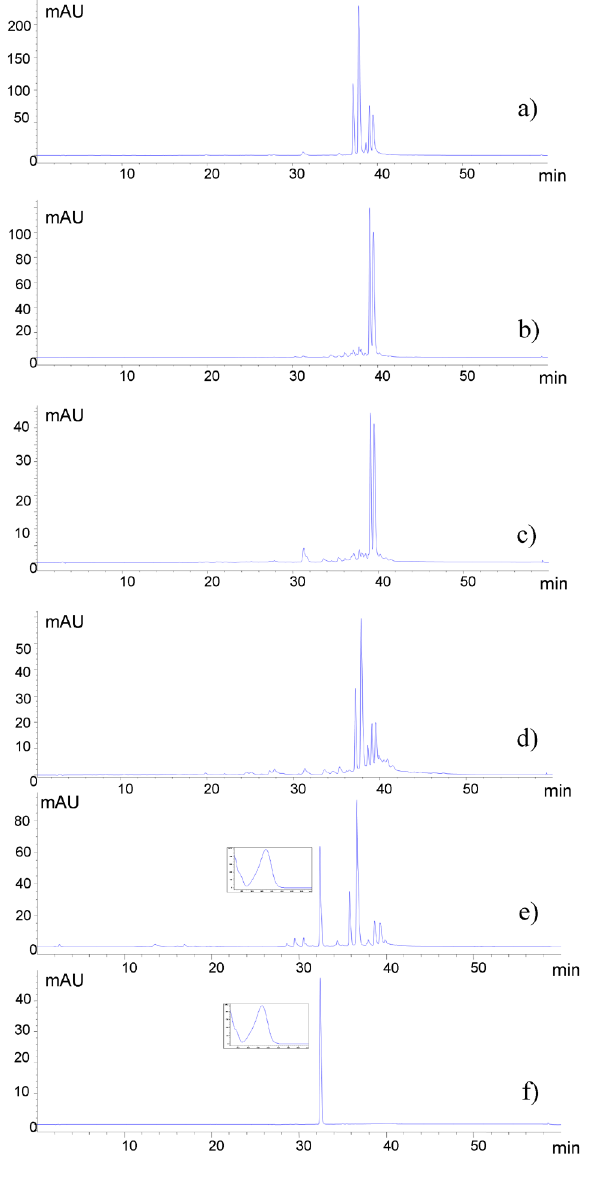
Figure 4: A HPLC chromatogram of the investigated samples HE (a), MgHE (b), KHE (c), SOXHE (d), XH4 (e), and standard xanthohumol (f), recorded at λ = 360 nm. The UV spectra of the compounds in the investigated samples at the retention time corresponding to the standard substance were shown.